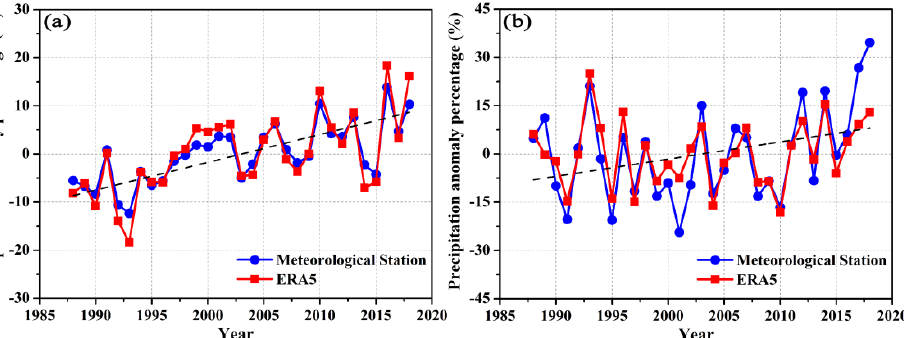
Figure 8. Summer mean temperature ( a ) and annual total precipitation anomalies ( b ) from the meteorological stations and ERA5 data near the glaciers in the Qilian Mountains. The black dash line represents the linear fit line of summer mean temperature or annual total precipitation anom- alies of the meteorological